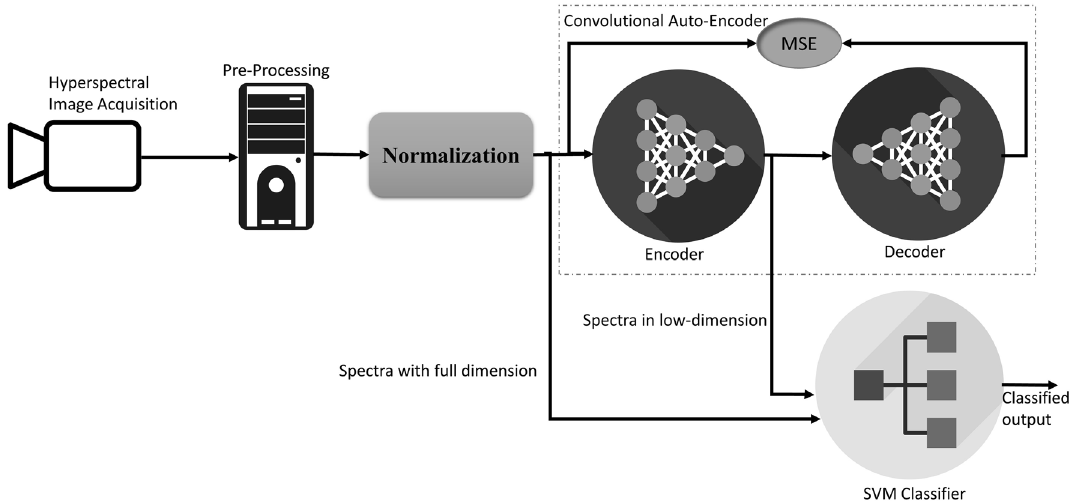
Figure 5. High level architecture of processing pipeline, the classifier accepts either one of the input based on